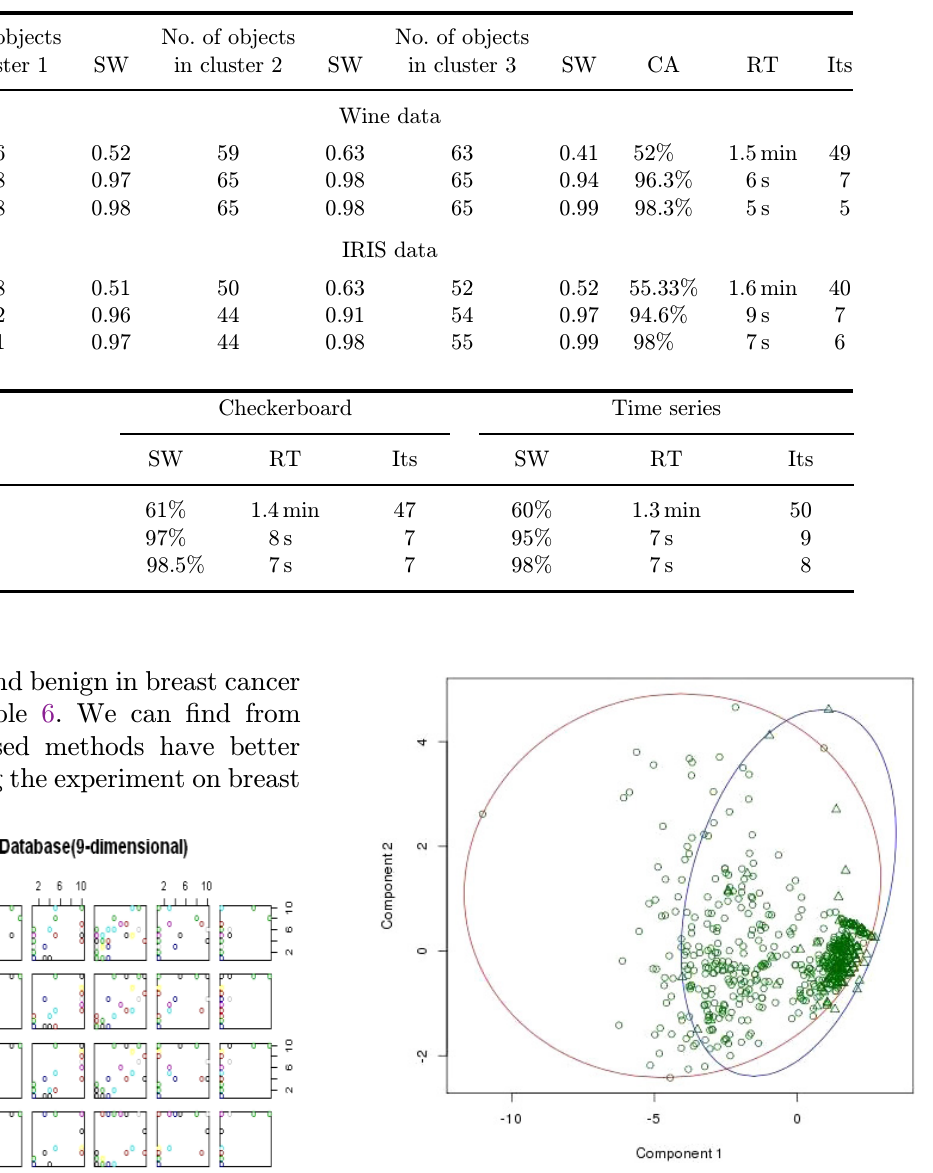
Table 5. Cluster results. Silhouette width [SW], Clustering Accuracy [CA], Minutes [M], Seconds [S], Running Time [RT] and Iterations [Its].